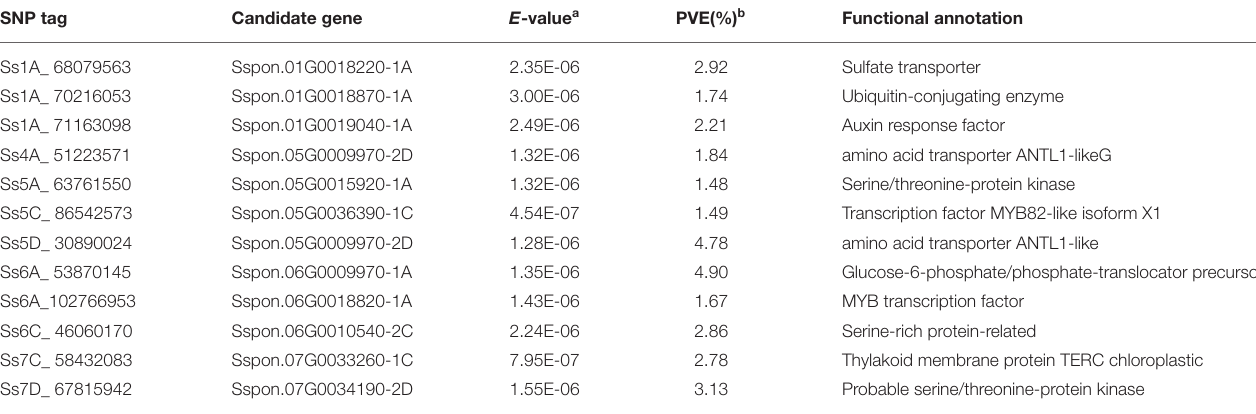
TABLE 2 | List of candidate genes associated with elite loci of sugarcane leaf angle.